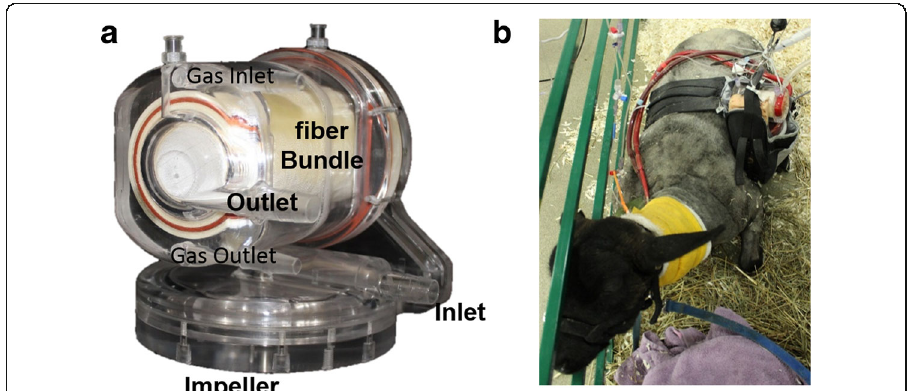
Fig. 1 Prototype of the adult low-flow ECCO 2 R ModELAS device showing the blood and gas flow pathways ( a ). All three respiratory assist applications utilize an identical pumping compartment. Cannulation and HFM bundle size differentiate each respiratory assist configuration. Photograph of a study animal wearing the holstered device ( b